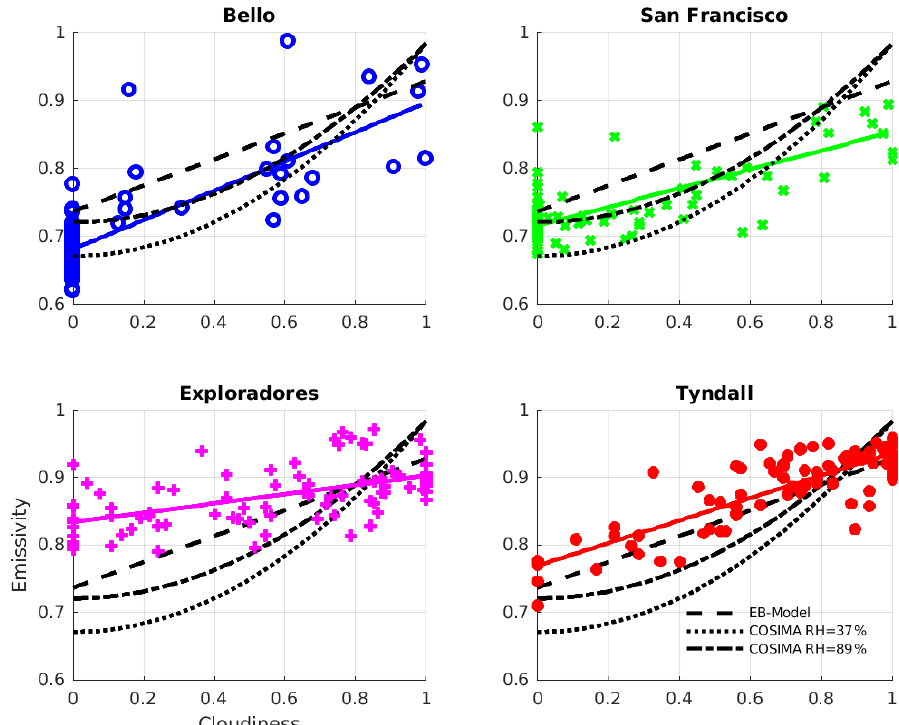
Figure 10. Measured emissivity of the atmosphere as a function of the cloudiness. The data points correspond to the daily emissivity obtained from Eq. (14) by using daily means of LW in and T plotted against the inferred daily cloudiness values. The solid colored straight lines correspond to linear fits to the data of every glacier and the discontinuous black lines correspond to the model parametrizations (same as Fig.